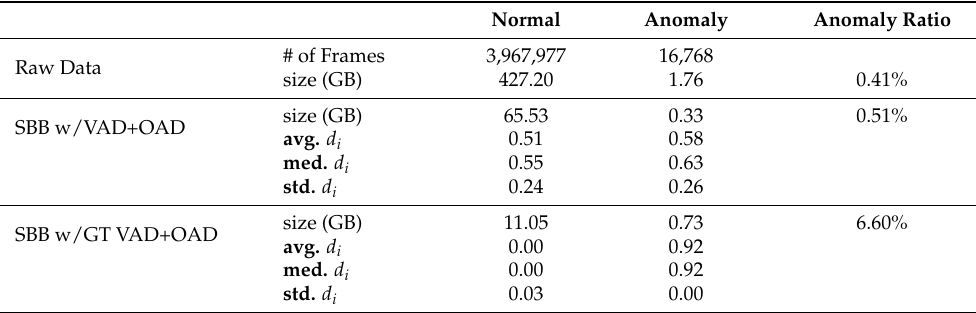
Table 5. Raw, SBB-compressed and ground-truth (GT) SBB-compressed data statistics on